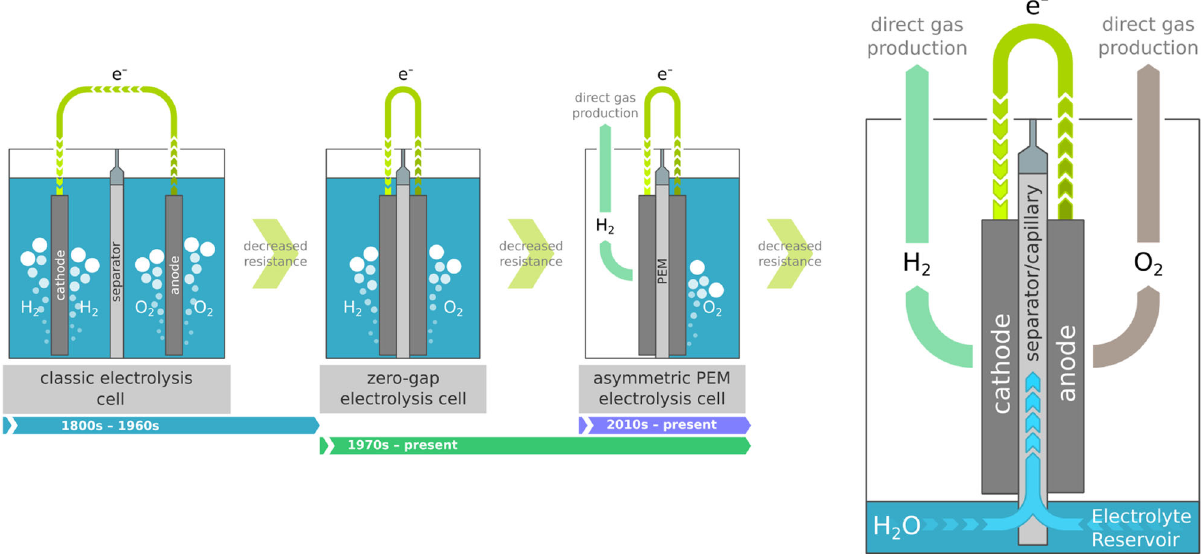
Fig. 1 Conceptualisation of the Capillary-Fed Electrolysis (CFE) cell. Inspired by the historic evolution of water electrolysis cell architectures culminating in the direct production of one of the gases, the Capillary-Fed Electrolysis cell directly produces both gases. Liquid electrolyte is continuously drawn up the separator by a capillary effect, from a reservoir at the bottom of the cell. The porous, hydrophilic separator sustains the fl ow rate required for water